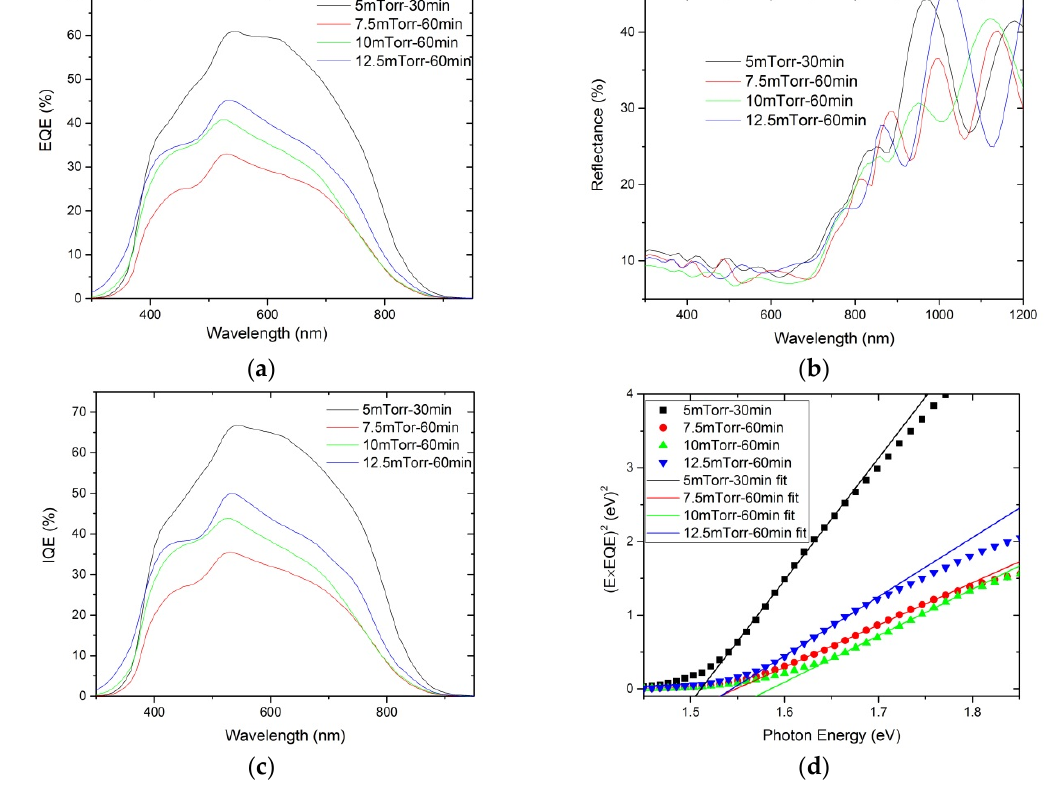
Figure 5. ( a ) External quantum efficiency (EQE) of CZTS devices with different precursor deposition parameters: 5 mTorr ‐ 30 min, 7.5 mTorr ‐ 60 min, 10 mTorr ‐ 60 min, and 12.5 mTorr ‐ 60 min; ( b )